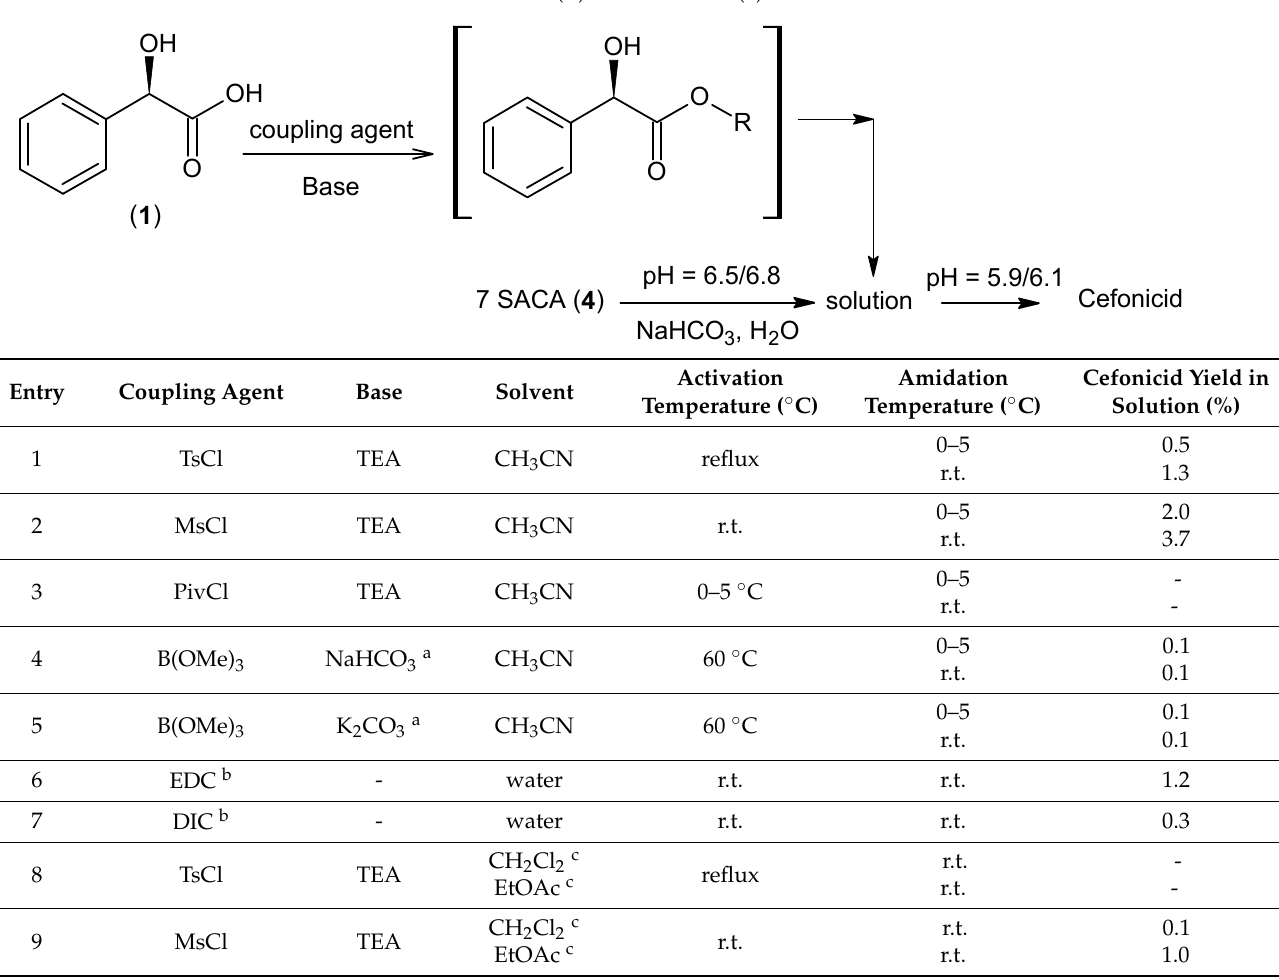
Table 1. Direct amidation of ( R )-mandelic acid ( 1 ).